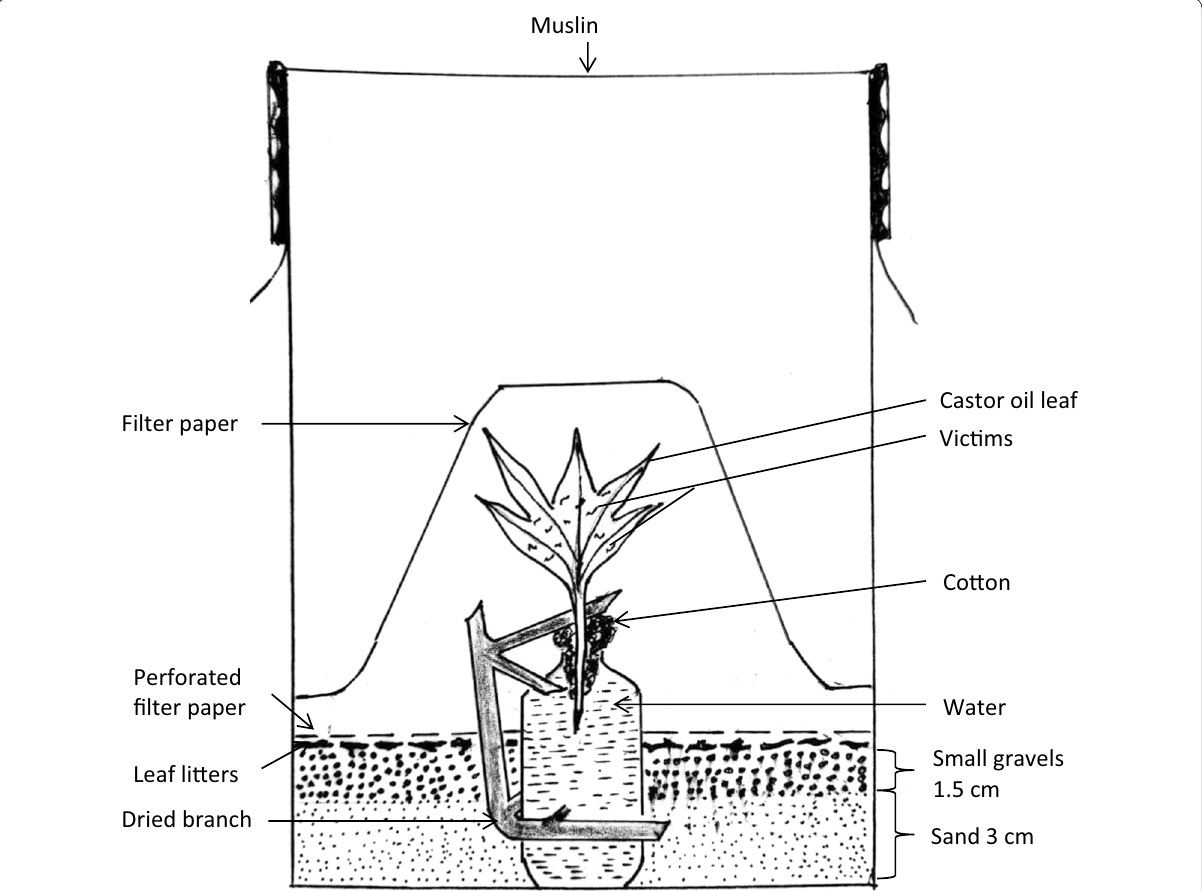
Fig. 2 Clear plastic jar for rearing the false-scorpion Olpium